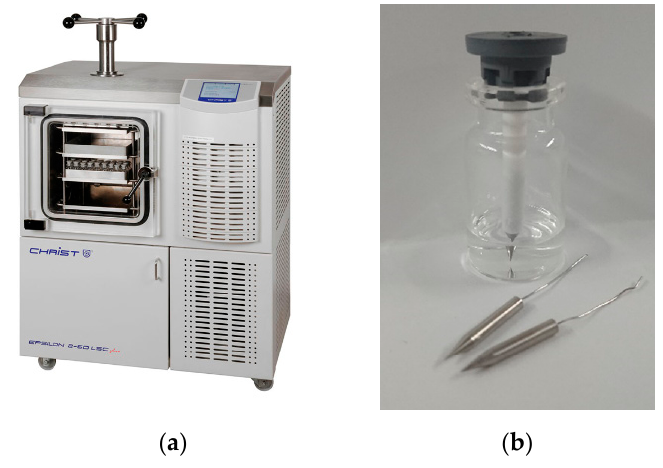
Figure 9. ( a ) Freeze-dryer Epsilon 2-6D [79] and ( b ) WTMplus sensors.